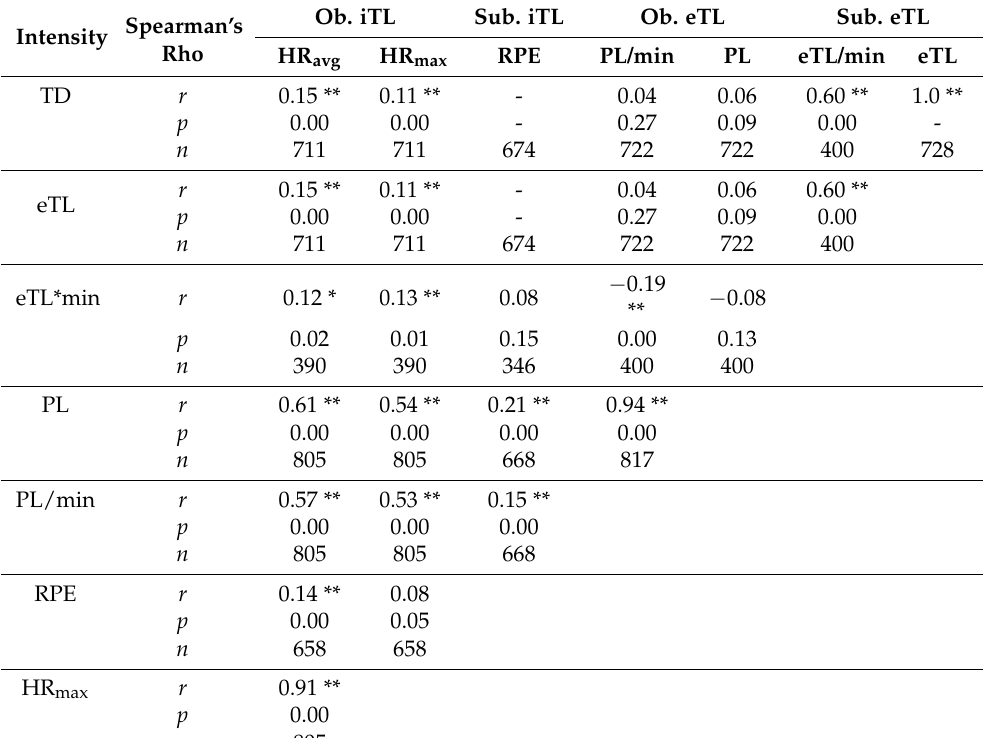
Table 5. Correlation analysis between the intensities recorded when apply to the 3 vs. 3